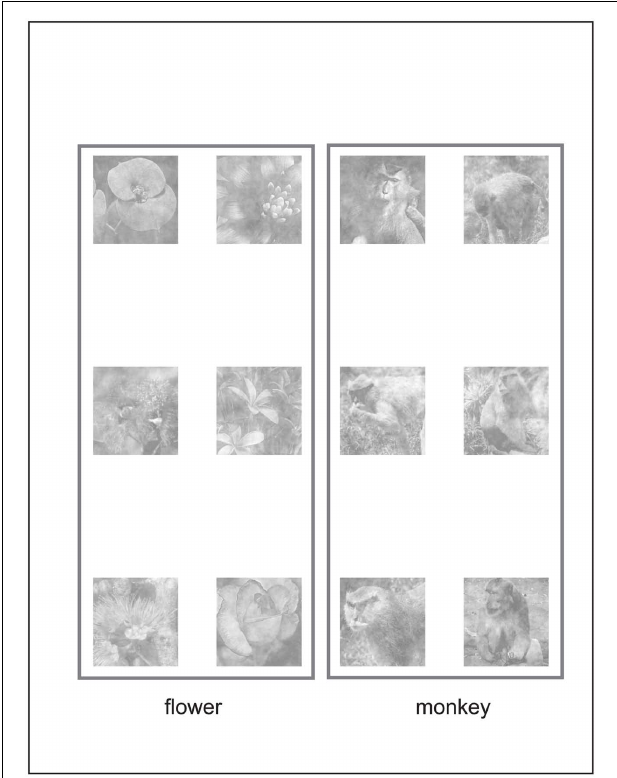
FIGURE 3 | Set of 12 familiar stimuli (100%